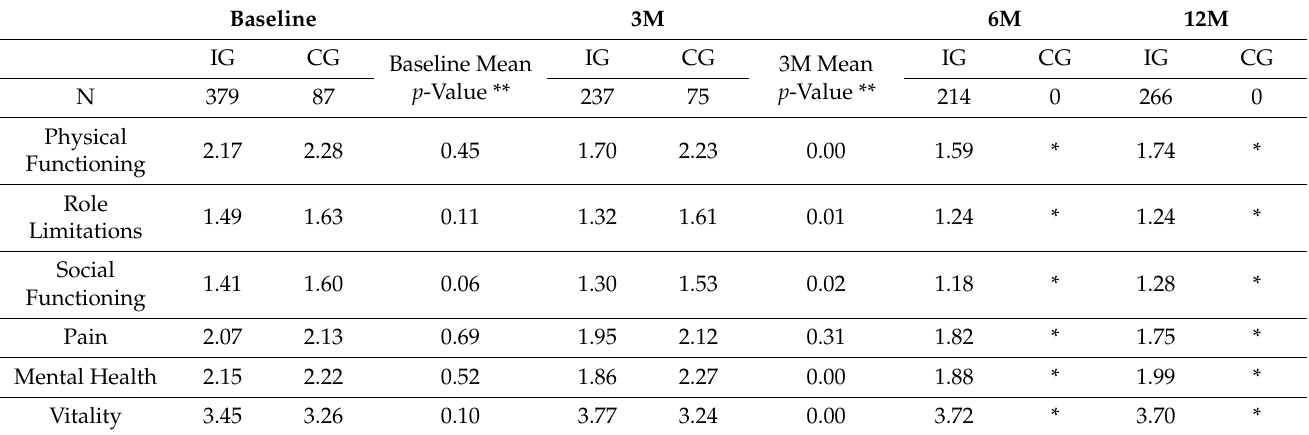
Table 2. Average value for components of SF-6D over time period by